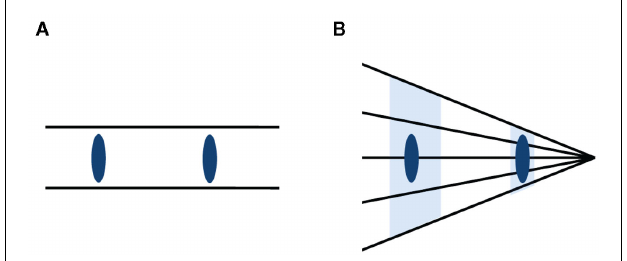
FIGURE 1 | Illustration of a visual illusion based on context. Two identical oval shapes are presented, either in a context suggesting that they are located at the same distance from the observer (A) or, using simple rules of perspective, in a context suggesting that one is further away than the other (B) . Most observers report experiencing different sizes in the (B) case, even though the retinal size of all oval shapes in all panels of the figure will be identical.This illusion is termed the Ponzo or corridor